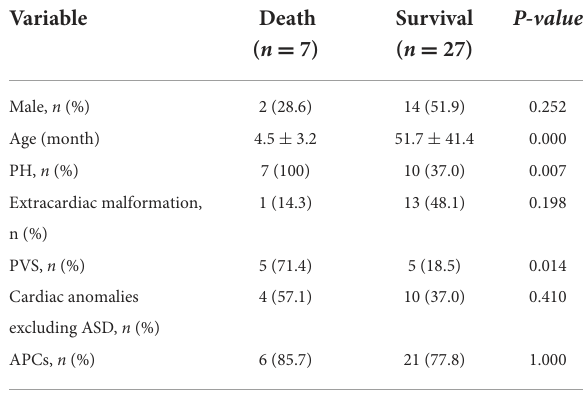
TABLE 4 Clinical characteristics of PH patients with different forms. Variable